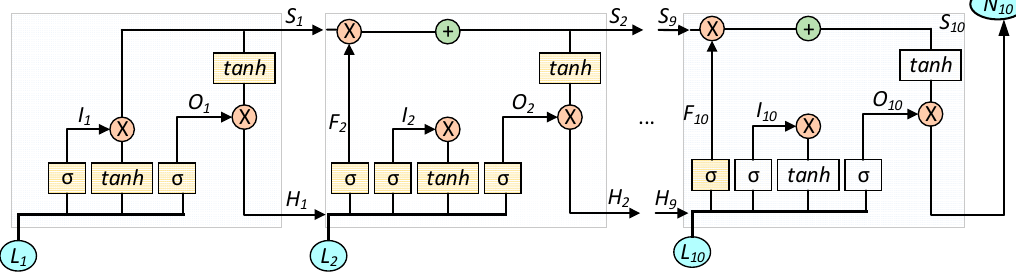
Figure 4. A basic structure of the LSTM-based RNN.